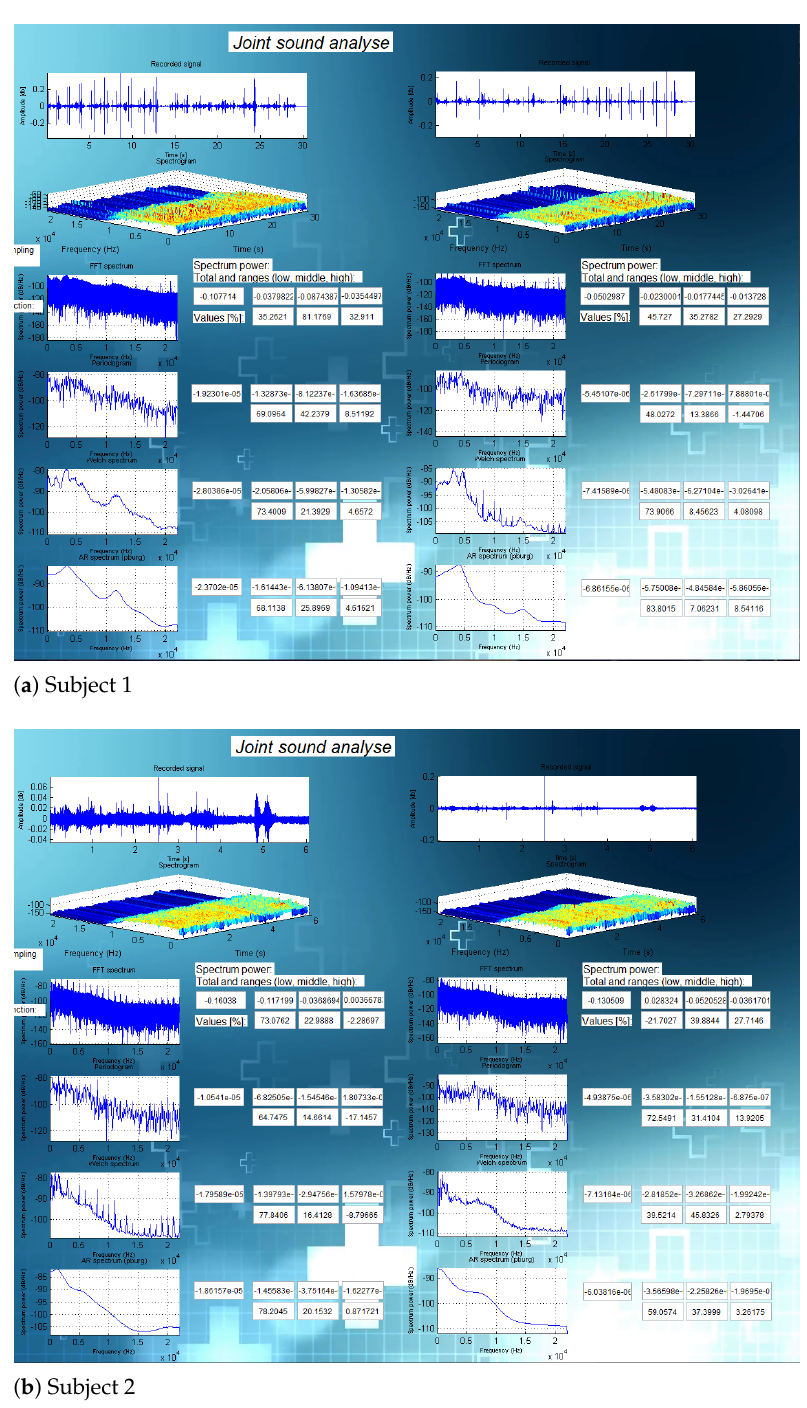
Figure 6. Test study analysis comparison. This situation may be caused by the imperfect design of the device, but also by the artifacts transferred from another device near the test apparatus during the recording. The artifacts do not affect the visual evaluation of the spectrum, and the frequency peaks that appear in the graph did not affect significantly the spectrum power